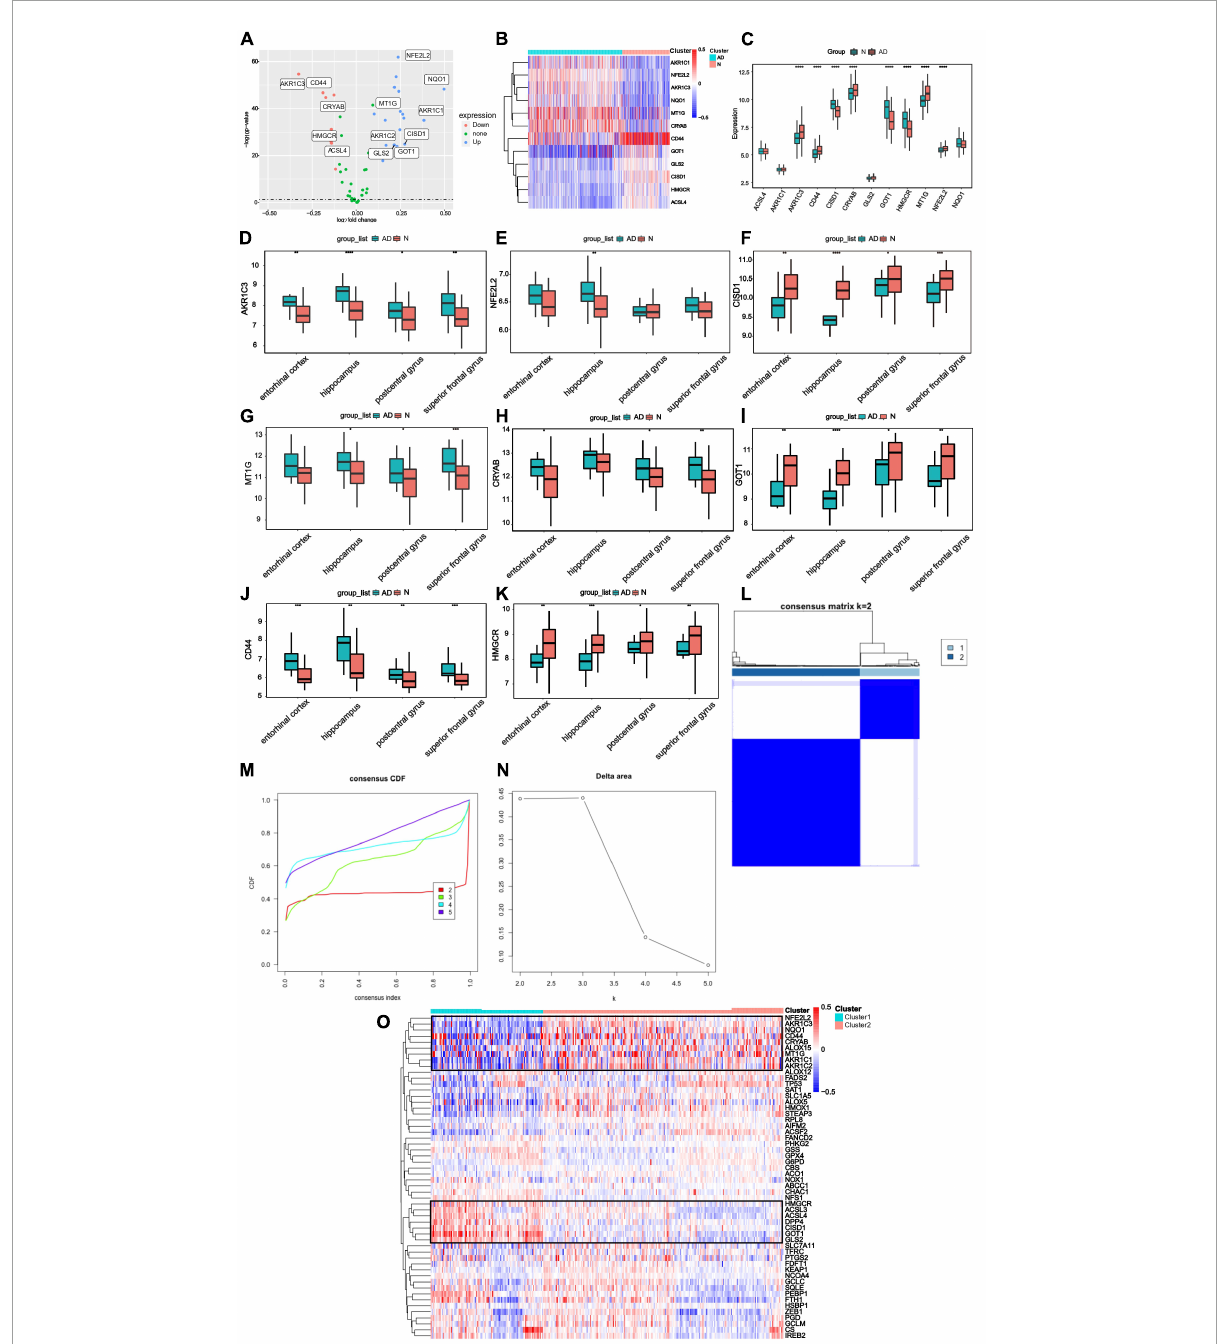
FIGURE2 Differential expressing analysis and consensus clustering analysis of ferroptosis regulating genes (A) DEGs were demonstrated in the volcano plot. Up-regulated genes were represented in blue and down-regulated genes were represented in red. The markers of the most different expressing genes were labeled in this diagram. (B) The expression profiles for 12 labeled genes. Red represented the increasing expression and blue represented decreasing expression. (C) The expression levels of 12 labeled genes were demonstrated with boxplots in GSE5281 and GSE48350, and it showed that eight FRGs had significant expression levels compared to the AD and Normal tissues. (Median line evaluated expression level and * indicted significant difference). (D–K) The expression level of genes was analyzed in entorhinal cortex, hippocampus, postcentral gyrus and superior frontal gyrus. (L) Consistent clustering at the index k = 2. (M) The cumulative distribution function (CDF) of clustering ( k = 2–5). (N) Delta area plot depicting the relative change under the CDF curve ( k = 2–5). (O) The expression level of FRGs in different clusters (The left side was cluster1, while the right side was